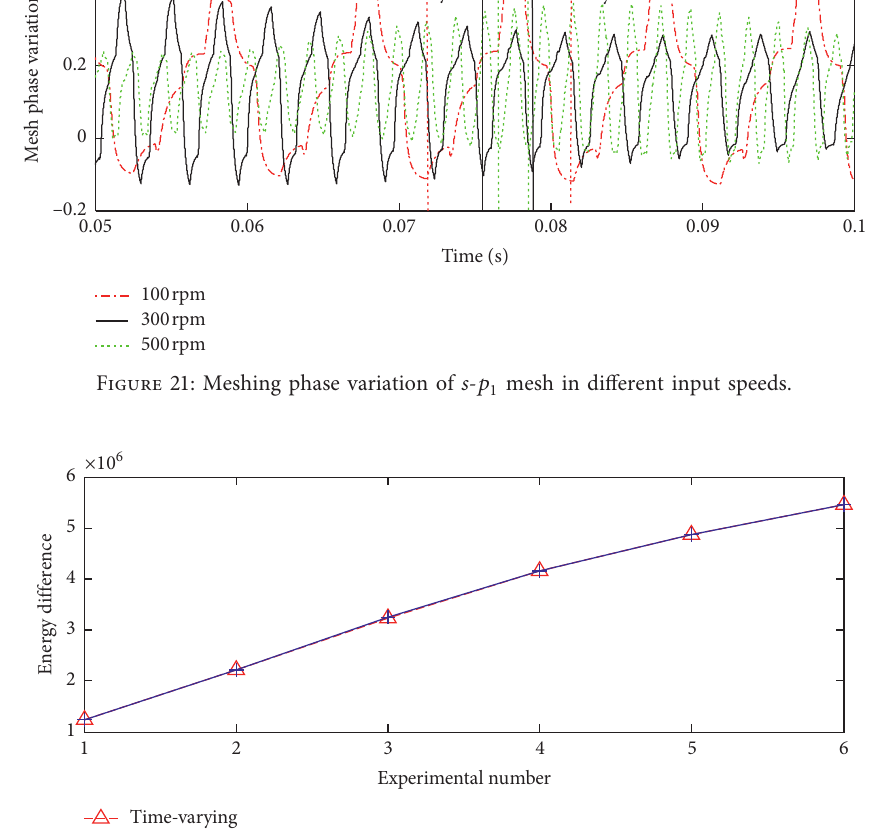
mesh in different input 1